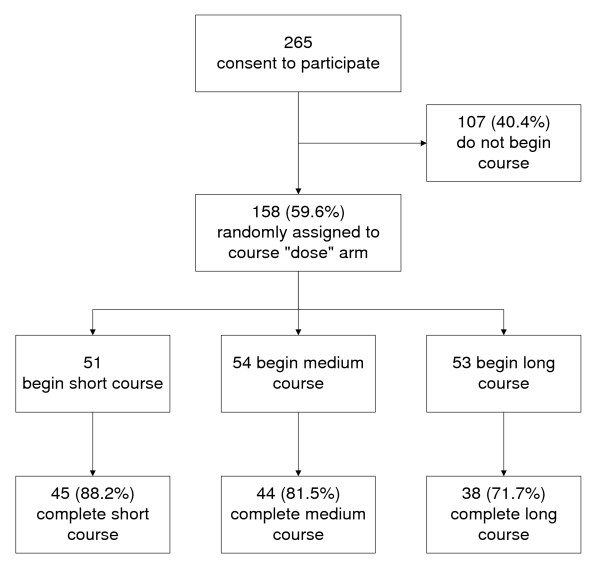
Recruitment and participation flowchart.